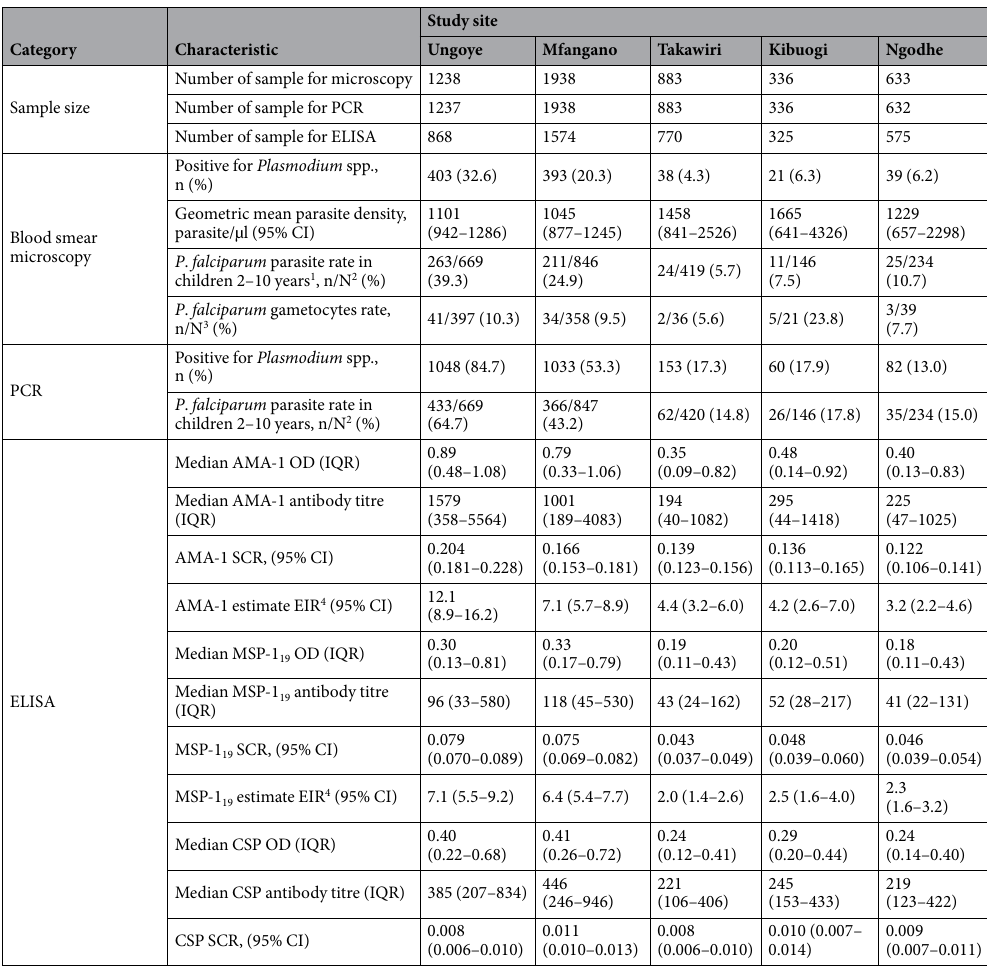
Table 2. Estimates of current malaria infection and exposure. 1 Total of two children has no data on microscopy. 2 Total numbers of children 2–10 years old tested. 3 Total P . falciparum positive by slide microscopy. 4 EIR was estimated from the SCR data using a previously described relationship 10 . OD, optical density; CI, confidence interval; IQR, interquartile range (25th–75th percentile); SCR, seroconversion